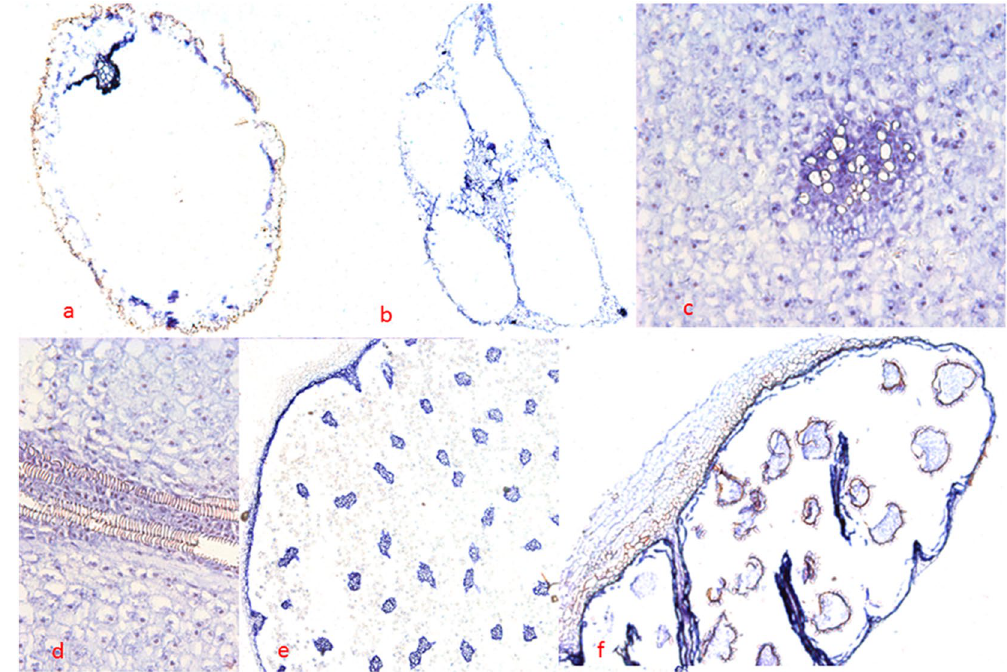
Figure 6. In situ hybridization of IsLFY2 expressions. ( a ) Transverse section of roots. ( b ) Transverse section of leaves. ( c ) Transverse section of corms. ( d ) Longitudinal section of corms. ( e ) Transverse section of microsporangia. ( f ) Transverse section of megasporangia. Scale bars were 300 μ m for megasporangia and microsporangia, 200 μ m for root, leaves, and 100 μ m for